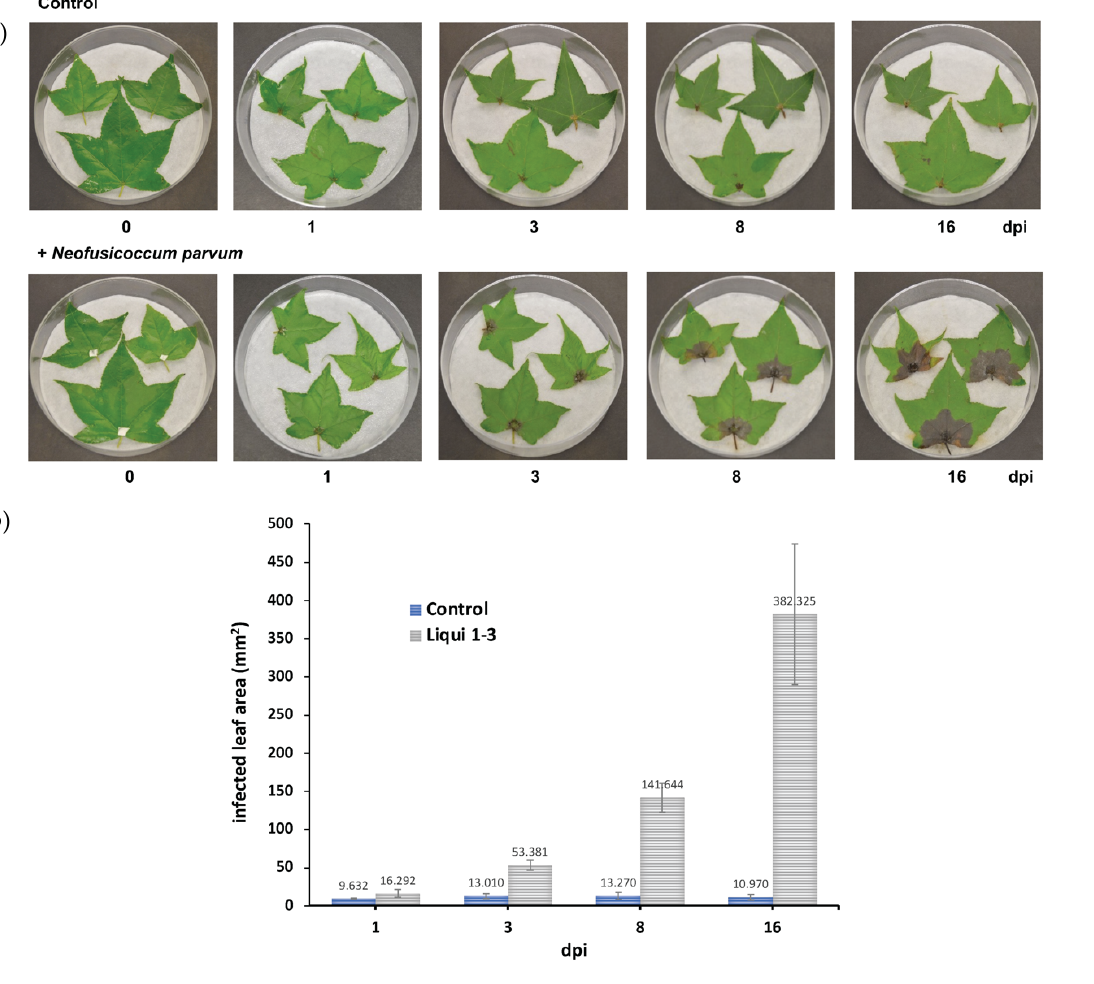
Figure 2. The N. parvum and L. styraciflua pathosystem. ( a ) The photographs were taken at 0, 1, 3, 8, and 16 dpi. Data are representative of at least three independent experiments. ( b ) The graph presents the leaf damage measured (mm 2 ) at 3, 8, and 16